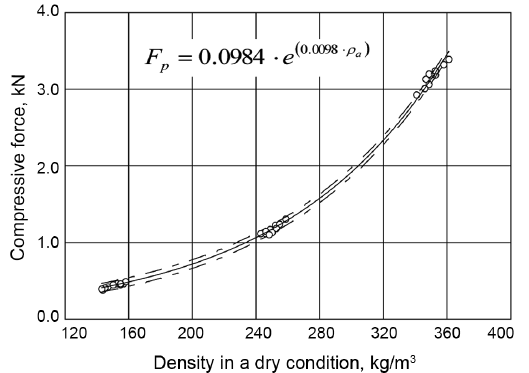
Fig. 6. The relationship between compressive force and density of lightweight composite: ○ – experimental data; (——) – re- gression line; (- - - -) – projected minimal and maximal